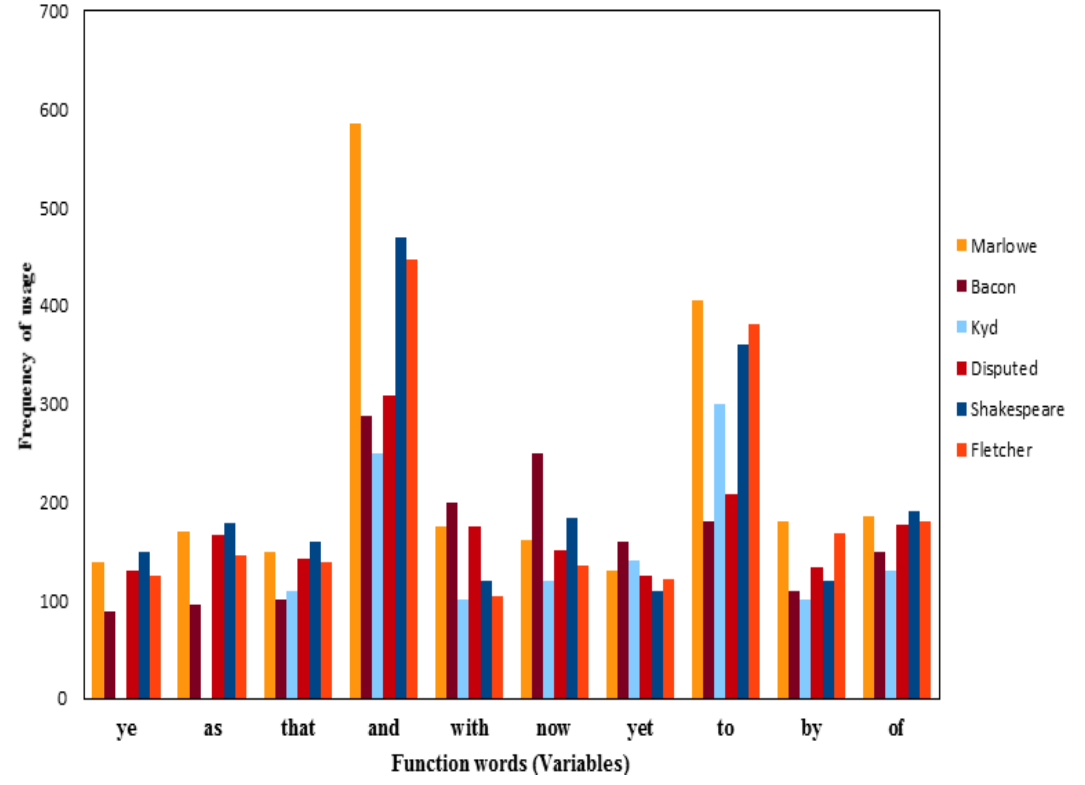
Figure 25. Function words centroid-based bar plot for all the authors